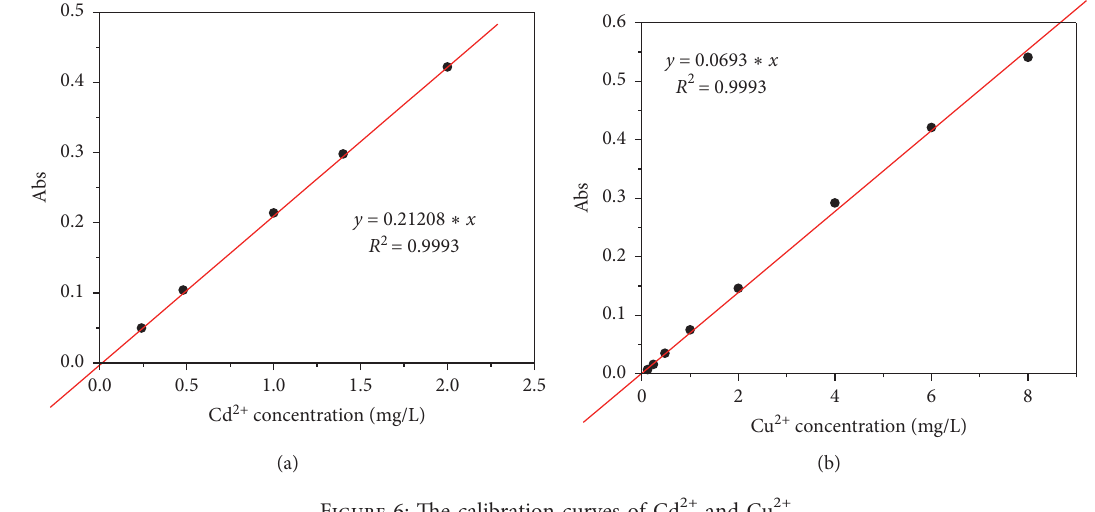
Figure 6: The calibration curves of Cd 2+ and Cu 2+ .